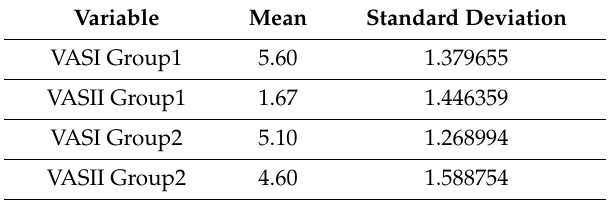
Table 13. Main descriptive statistics for pain intensity changes in VAS Visual Analogue